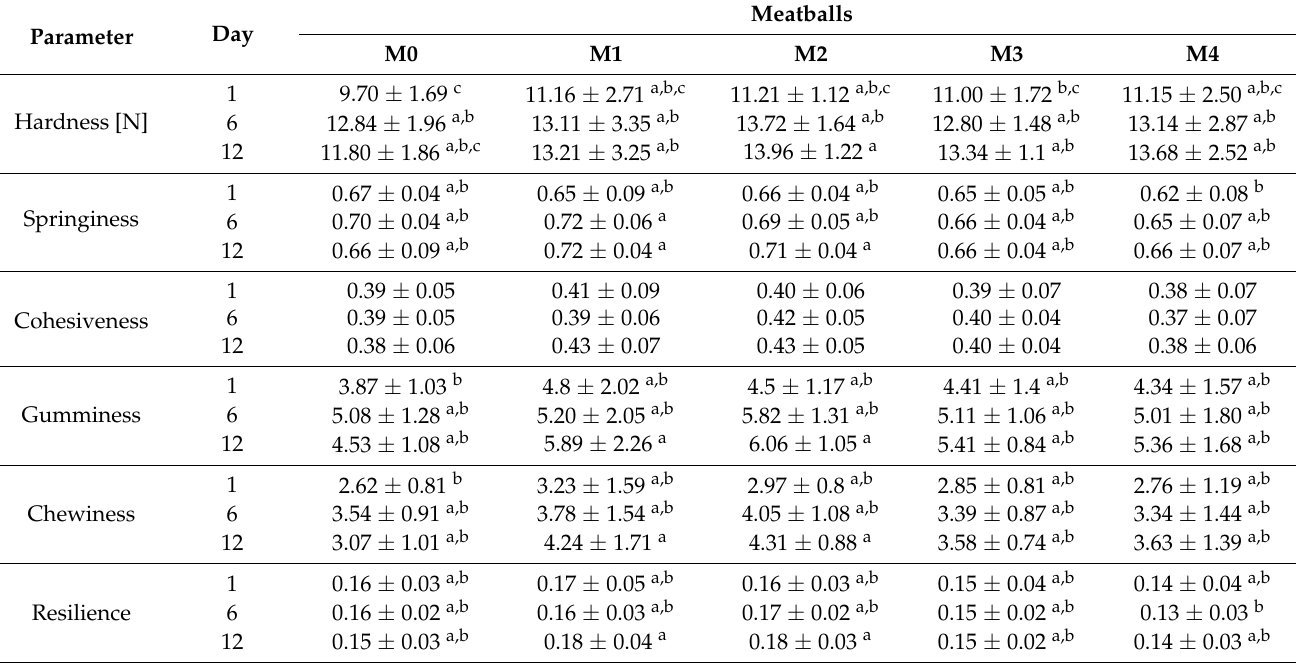
Table 4. Texture profile analysis of the five variants of cooked meatballs stored in refrigerated conditions; mean ± SD.